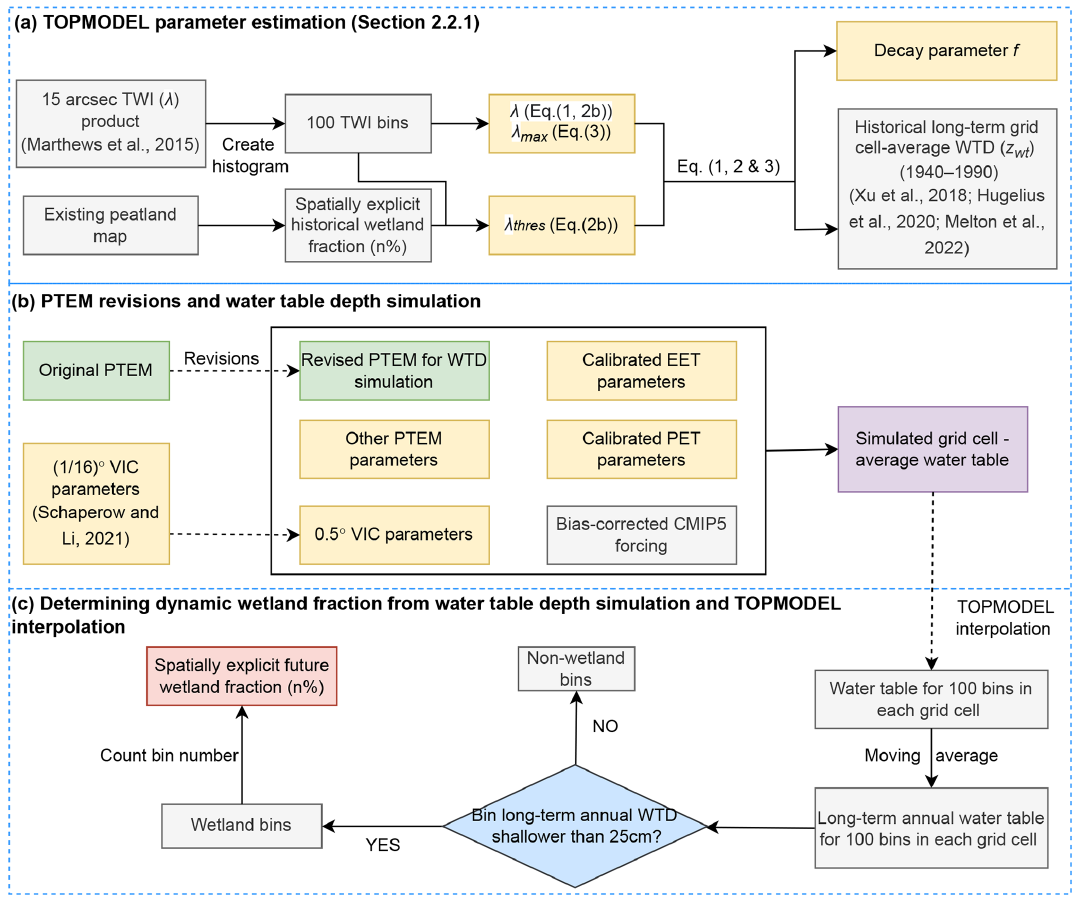
Figure 1. Flow chart for Sect. 2.2, “Future grid cell average WTD simulation”, in the Methods section.